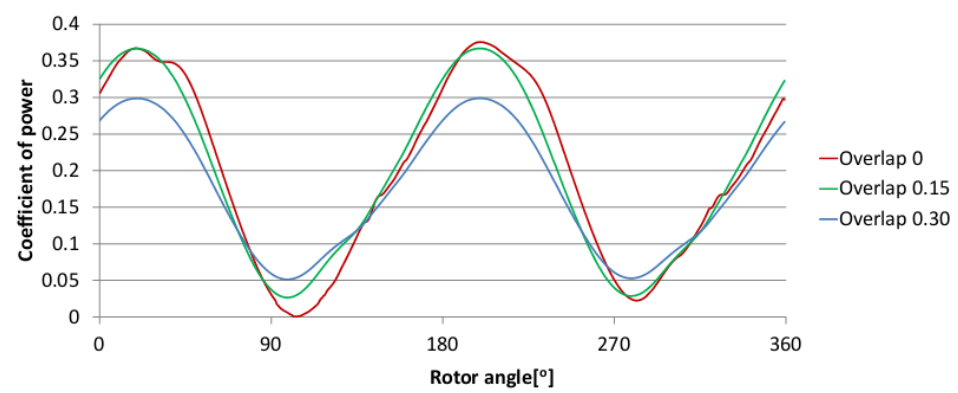
Figure 7: Coefficient of power for the Classical Savonius wind turbines with different overlap ratios versus angular rotor position at TSR =